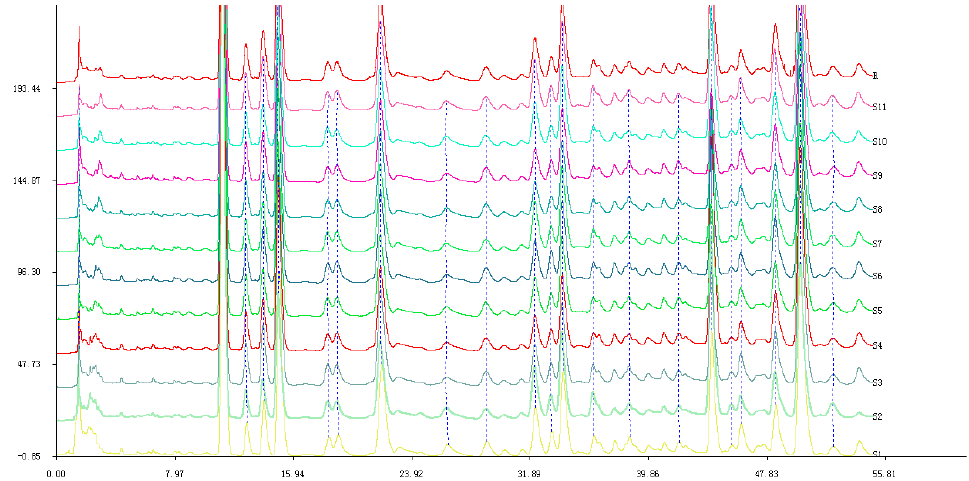
Figure 1. The characteristic HPLC chromatogram of TDL from S. chinensis .